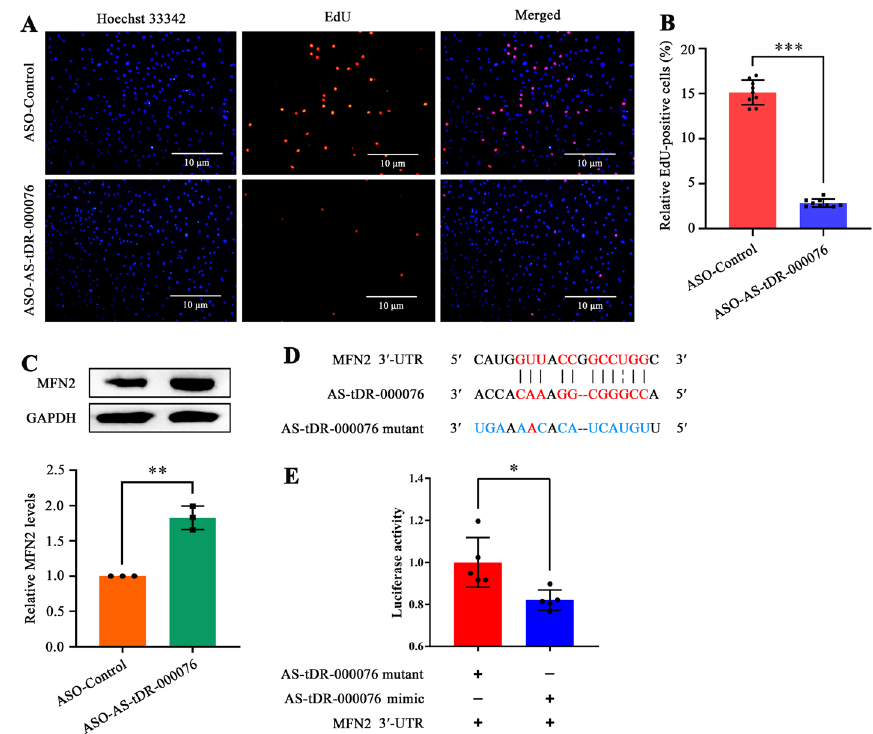
Fig. 5 AS‑tDR‑000076 silencing restrains HASMC proliferation by augmenting MFN2 levels. A EdU incorporation assay of HASMCs transfected with ASO‑Control or ASO‑AS‑tDR‑000076. Blue fluorescence (Hoechst 33342) indicates cell nuclei, while red fluorescence (EdU) represents HASMCs with DNA synthesis. Scale bar 10 µm; B Relative EdU‑positive HASMCs. Data shown as the ratio of EdU‑positive HASMCs to total ones. Data expressed as mean SD of at least three independent experiments, *** p < 0.001 ± versus ASO‑Control group; C Western blot analysis of MFN2 in HASMCs transfected with ASO‑Control or ASO‑AS‑tDR‑000076, with GAPDH as control. Data shown as mean SD of three independent experiments, ± ** p < 0.01 versus ASO‑Control group; D Schematic of binding sites of AS‑tDR‑000076 to MFN2 3 ′ ‑UTR; E Confirmation of MFN2 3 ′ ‑UTR as a target of AS‑tDR‑000076 employing the dual‑luciferase reporter gene assay. Data shown as mean SD of at least three independent experiments, * p < ±